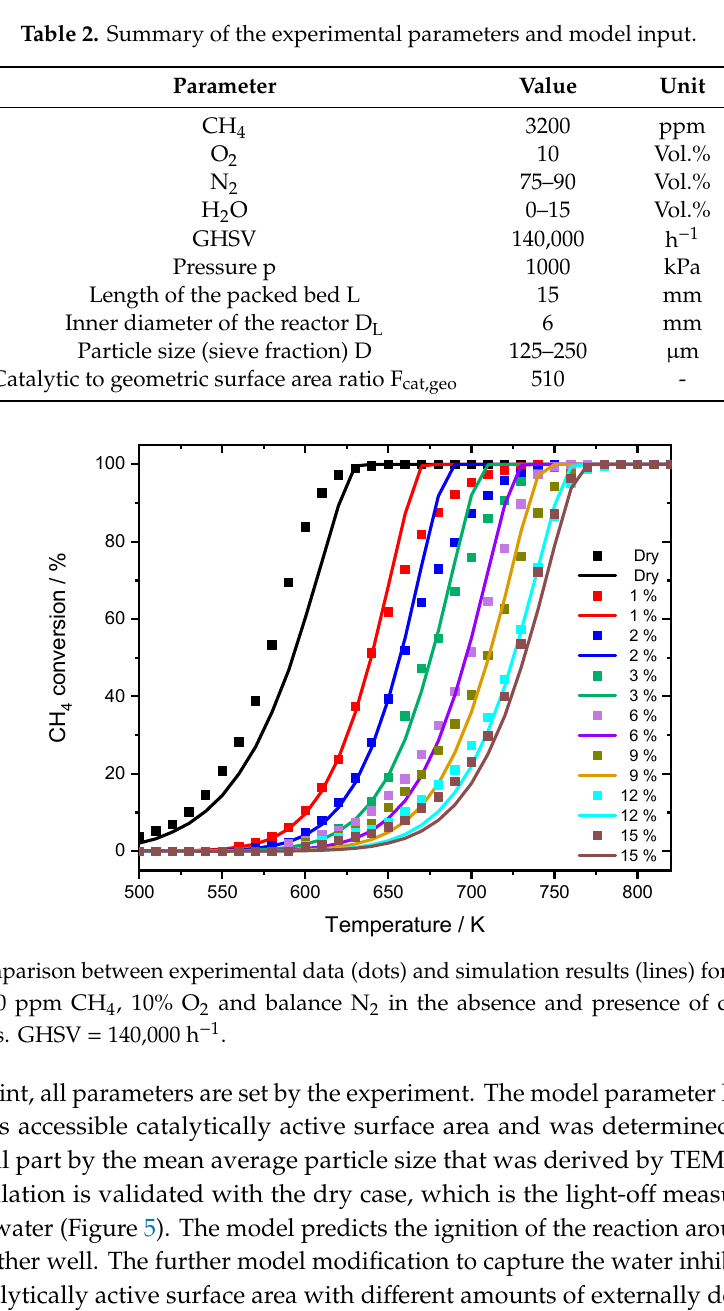
Figure 6. Results for the obtained change of the catalytically active surface area in comparison to the experimental shift in T 50 for the light-off measurements in absence and presence of externally dosed water.